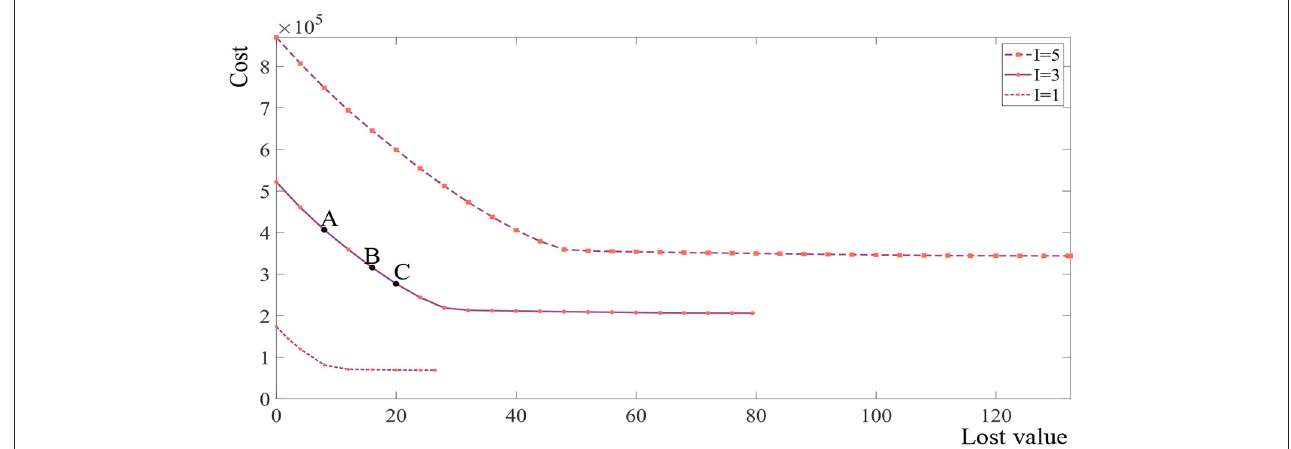
FIGURE3 Distribution of the Pareto front of the